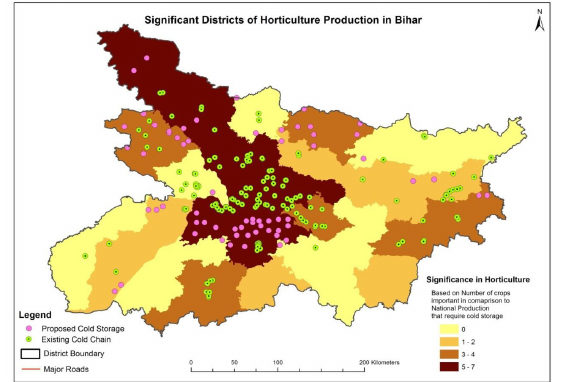
Figure 14. A visual comparison of the horticultural important districts and cold storage distribution as per the